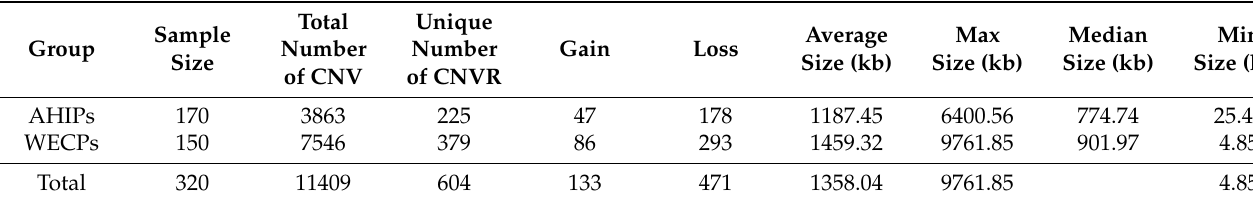
Table 1. The distribution of CNVRs in the pig autosomes.